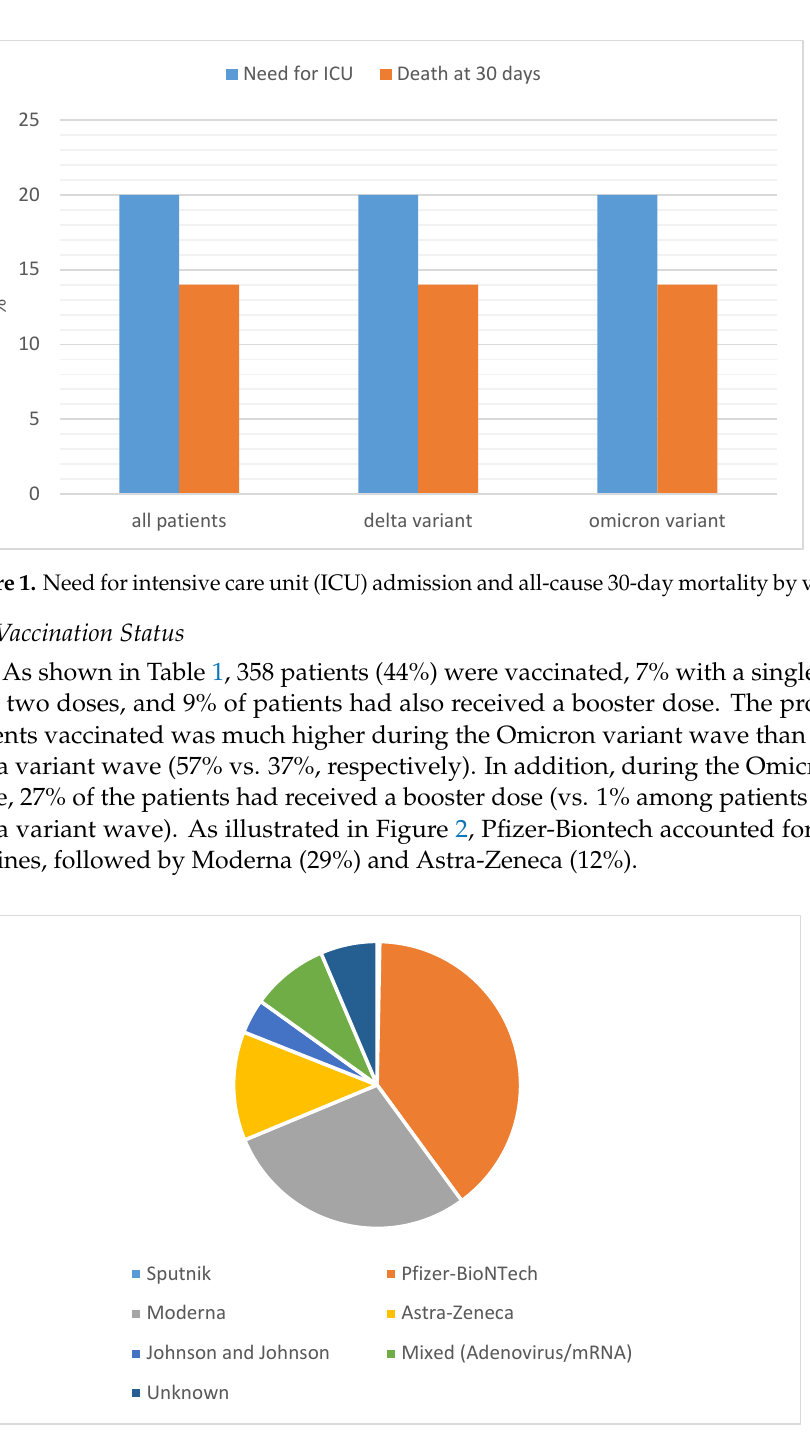
Figure 2. Types of COVID ‐ 19 vaccine received (relative percentages).